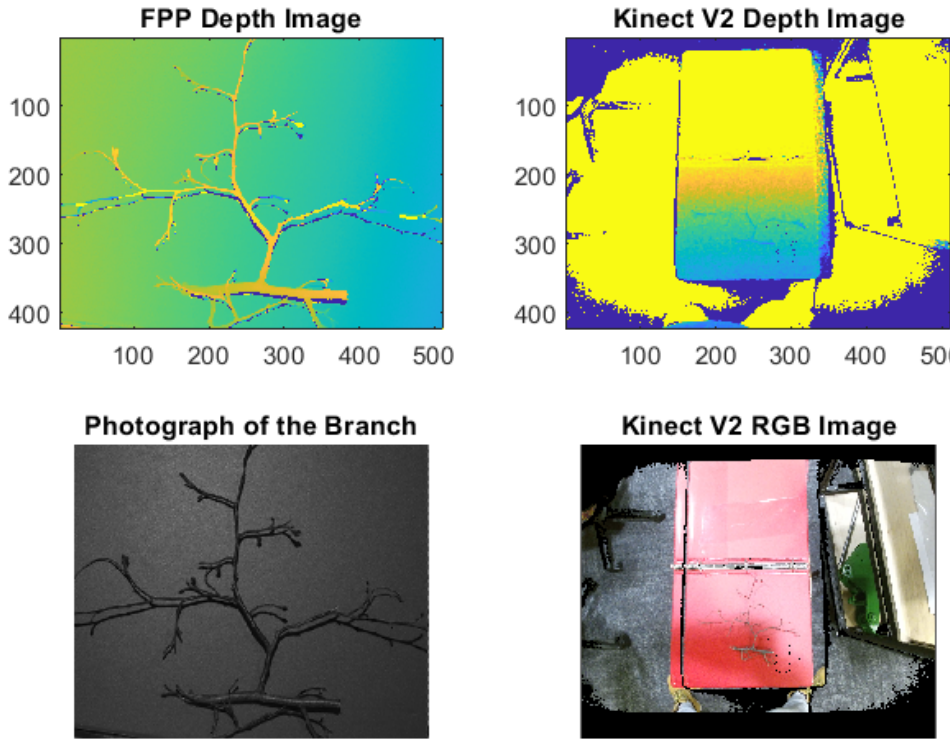
Figure 14. FPP vs. Kinect V2’s TOF Depth Image of a Tree Branch. Both of these images are generated with the resolution of 512 ×